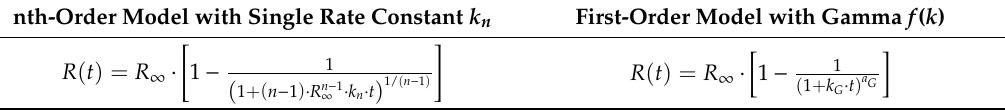
Table 3. nth-order model with deterministic rate constant k n versus. nth-Order Model with Single Rate Constant k